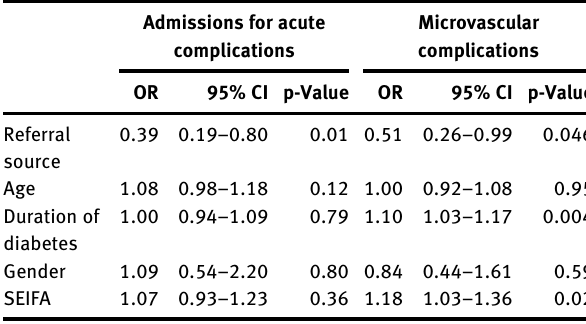
Table  : Logisticregressionanalysisexploringhospitaladmissions and microvascular